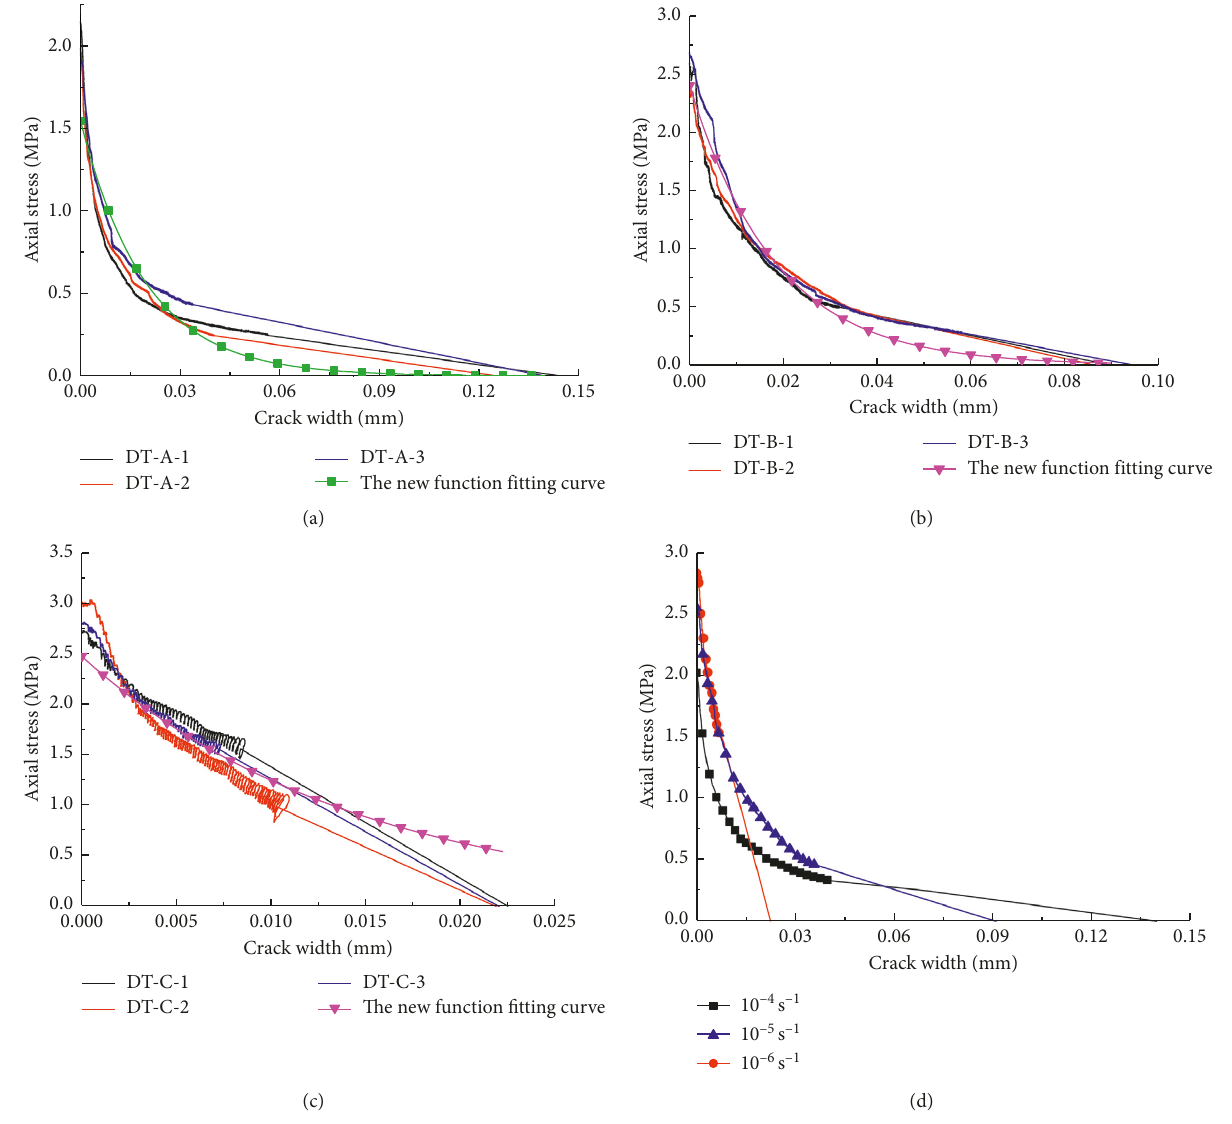
Figure 8: The result comparison of experimental and fitting curve of new function. (a) 10 curve of